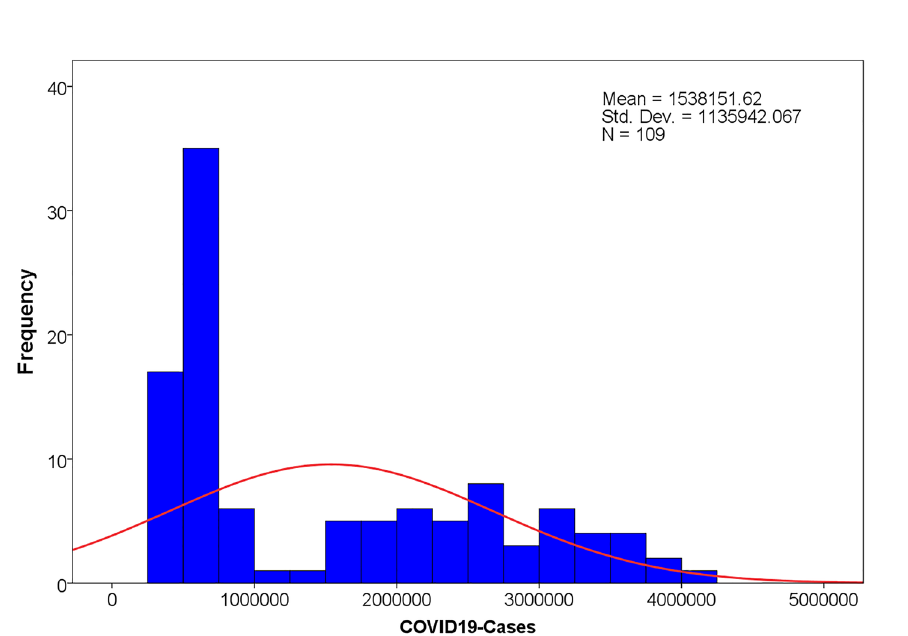
Figure.1. The histogram chart of the daily confirmed cases of